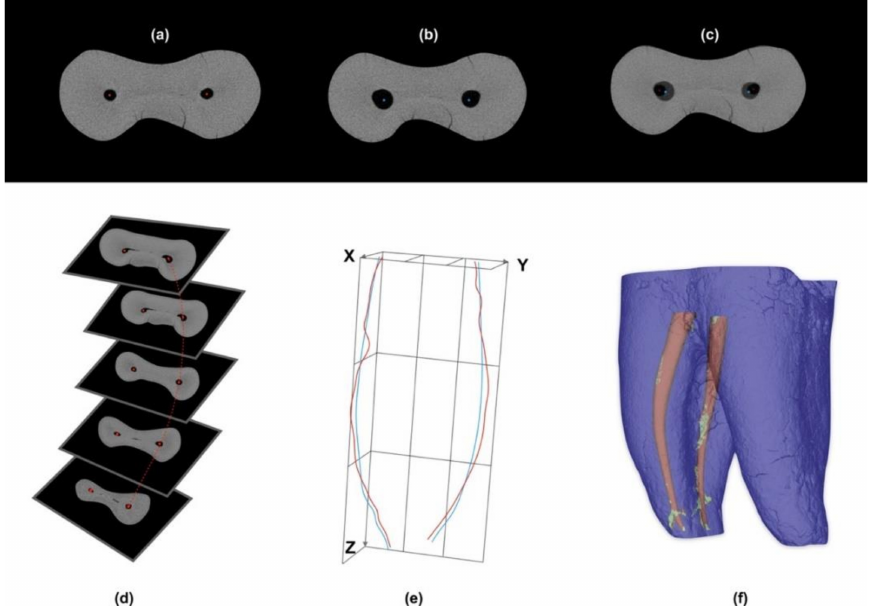
Figure 1. ( a ) Center of mass before instrumentation. ( b ) Center of mass after